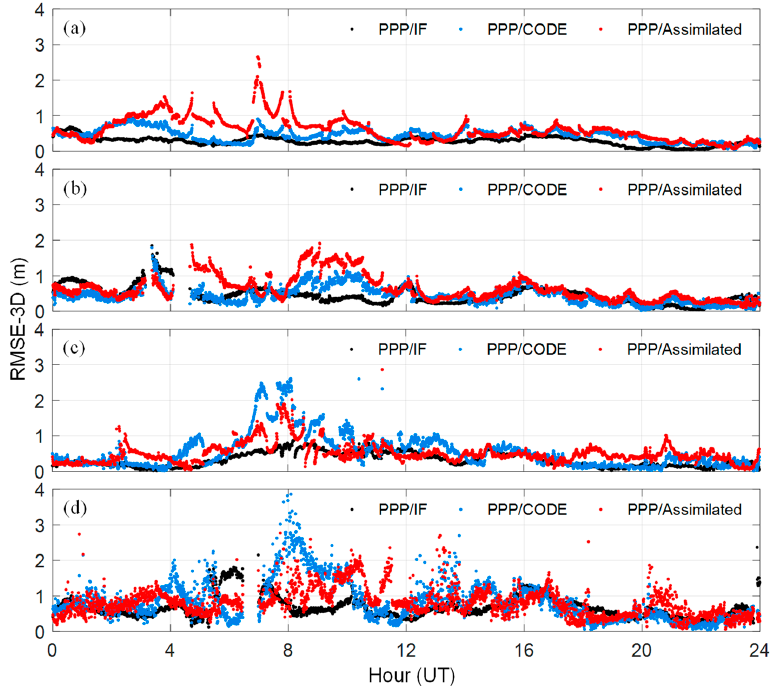
Figure 5. RMSE of 3D with each epoch at different stations on 6 September 2017. ( a ) GAMG; ( b ) JFNG; ( c ) LHAZ; ( d ) CMUM.